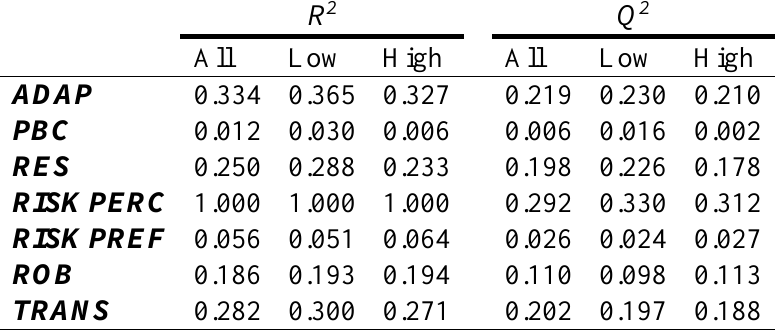
Table A1.1 . R 2 and Q 2 values of the structural model R 2 Q